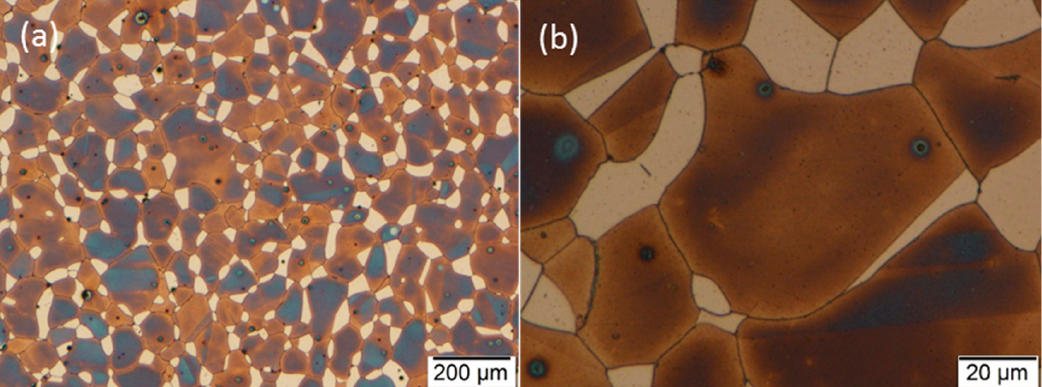
Figure 7. Optical microscopy of the sample that was isothermally annealed at 550 °C, etched with 10% nital, ( a ) ferrite–– white, and austenite––dark brown and violet, ( b ) magnified detail, there is a strong precipitation on the grain boundaries, ferrite–ferrite, ferrite–austenite, and austenite–austenite.